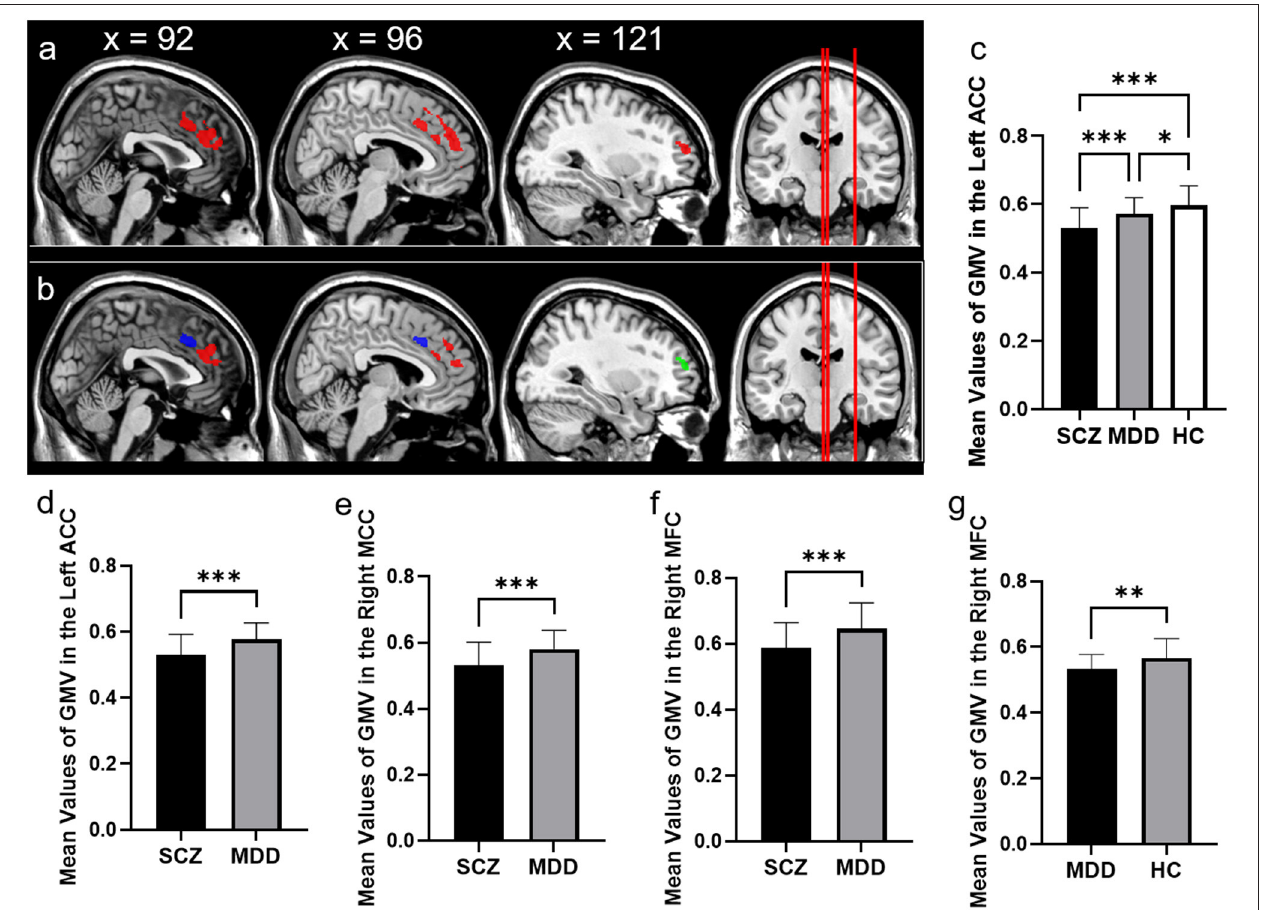
FIGURE 2 | Comparison of GMV in schizophrenia, major depressive disorder, and healthy controls. (a) The significant brain region that showed significant differences among patients with SCZ, patients with MDD, and HCs. (b) The significant brain region which showed significant differences between SCZ patients and MDD patients (controlling for age, gender, education, and total volume of the whole brain, p < 0.05, cluster-level whole-brain FWE corrected). The bar graphs showed the mean values of GMV in the left anterior cingulate cortex among three groups. (c) The left anterior cingulate cortex between SCZ and MDD. (d) The right median cingulate cortex between SCZ and MDD. (e) The right middle frontal cortex between SCZ and MDD. (f) The right middle frontal cortex between MDD and HC. (g) ACC, anterior cingulate cortex; MCC, median cingulate cortex; MFC, middle frontal cortex, * p < 0.05, ** p < 0.01, *** p < 0.001, Bonferroni